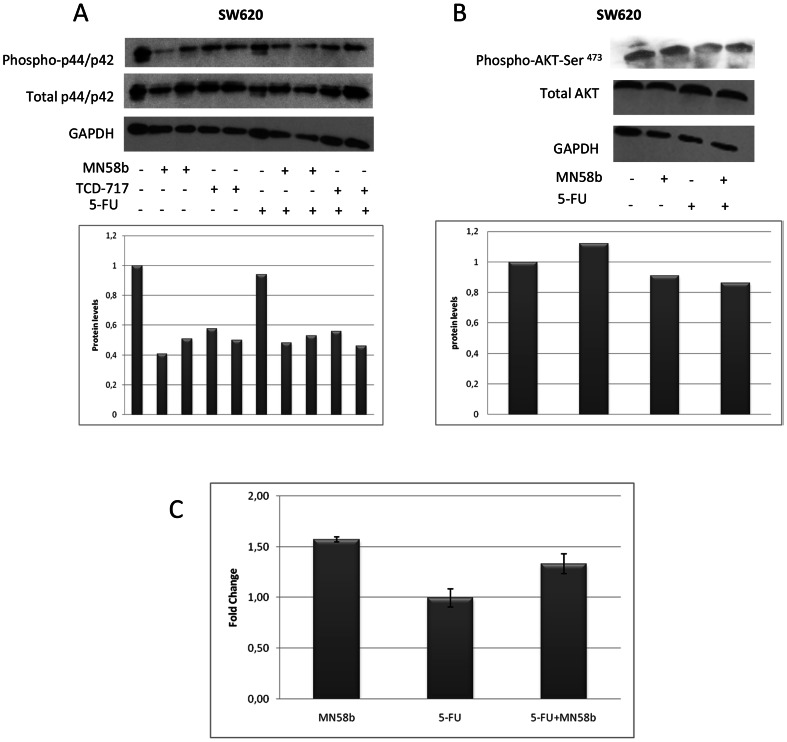
Effects of ChoK inhibition on p44/p42 MAPK levels and ceramide levels.(A) 2,5×105 SW620 cells were seeded in 6 well plates and incubated for 24 h and exposed to two concentrations of ChoKα inhibitors [TCD-717: 6 µM (left line) or 10 µM (right line); MN58b: 10 µM (left line) or 15 µM (right line)]. Where indicated, medium was removed after treatment with ChoKα inhibitors and changed for fresh medium with 5.5 µM 5-FU for an additional 24 h. Protein expression was analyzed by western blot using monoclonal anti-phospho p44/p42 MAPK and anti-p44/p42 MAPK. The figure shows a representative blot of two independent experiments. (B) SW620 cells were grown and treated as indicated in (A) with 15 µM MN58b and 5.5 µM 5-FU alone or in combination for 24 hours. Protein expression was analyzed by western blot using anti-pAKT- Ser473, anti-AKT or anti-GAPDH. The figure shows on the top a representative blot, at the bottom protein levels (pAKT-Ser473/total AKT/GAPDH) from a representative experiment. (C) 2×106 SW620 cells were seeded in p100 plates and incubated 24 h under standard conditions. Cells were then treated with 15 µM MN58b and 5.5 µM 5-FU alone or in combination for 24 hours. Total ceramide levels were analyzed by UPLC-TOF. Mean ± SD of two independent experiments performed in triplicate are shown.